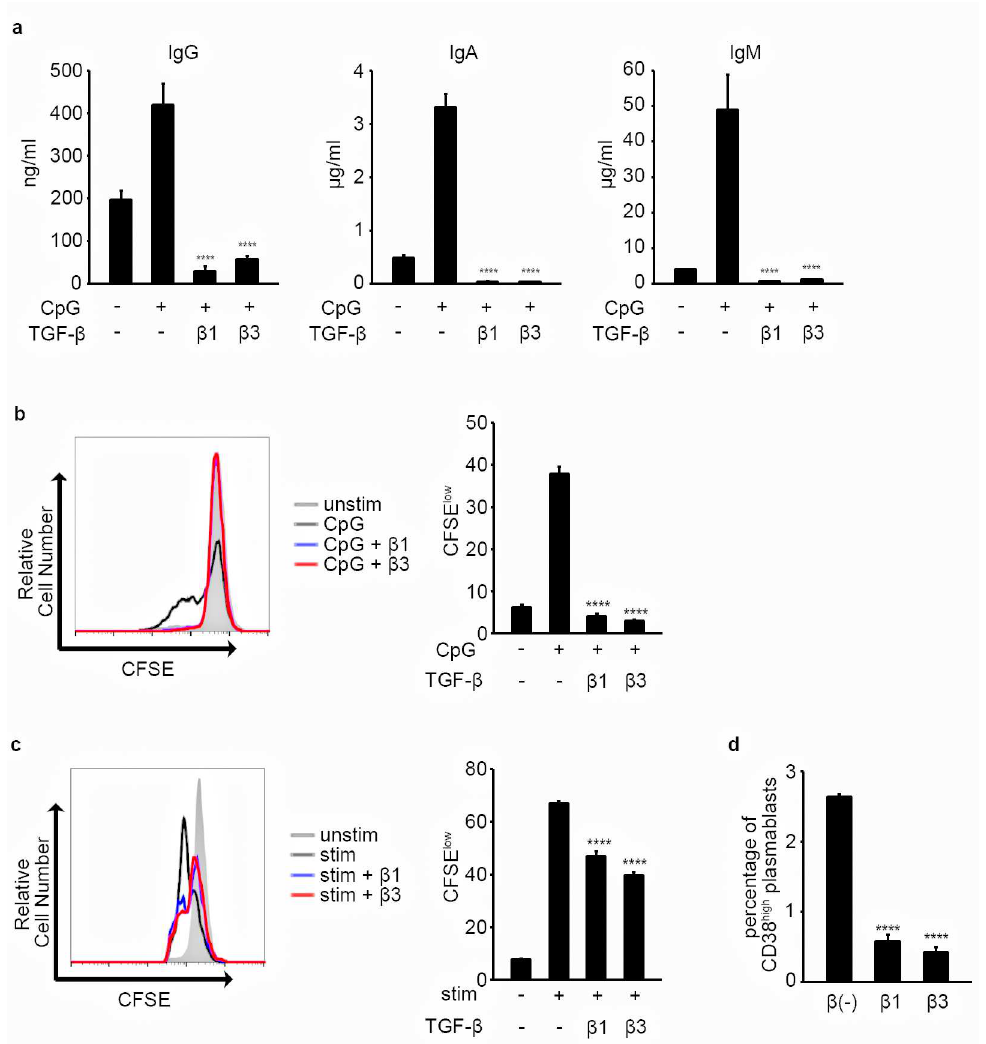
Fig 3. TGF- β 1 and β 3 inhibit B cell function under various stimulatory conditions. (a) B cells were stimulatedwith CpG-ODN2006 for 8 days, and antibody productionwas assessedby ELISA. Among the CpG-ODN2006 stimulated samples, each of the TGF- β treated samples was comparedwith TGF- β untreated sample using one way ANOVA, Dunnett test (n = 3). Results are representative of two independentexperiments. (b) B cells were stimulatedwith CpG-ODN2006for 6 days, and proliferation of CD19 + 7AAD - cells was assessed by flow cytometry. The graph on the right indicatesthe percentage of CFSE low cells amongCD19 + 7AAD - cells. Among the CpG-ODN2006 stimulatedsamples, TGF- β treated cells were comparedwith TGF- β untreatedcells using one way ANOVA, Dunnett test (n = 3). Results are representative of two independentexperiments. (c) B cells were cultured under IL-21, sCD40L, CpG-ODN2006,and BCR stimulationfor 4 days, and proliferation of CD19 + 7AAD - cells was assessed by flow cytometry. The graph on the right indicatesthe percentage of CFSE low cells among CD19 + 7AAD - cells. Among the stimulatedsamples, TGF- β treated cells were comparedwith TGF- β untreatedcells using one way ANOVA, Dunnett test (n = 3). Results are representative of two similar experiments. stim: IL-21, sCD40L, CpG-ODN2006,and BCR stimulation.(d) B cells were cultured under CpG-ODN2006 and BCR stimulationfor 6 days, and the percentageof CD38 high plasmablasts among CD19 + 7AAD - B cells was assessed by flow cytometry. TGF- β treated cells were comparedwith TGF- β untreated cells using one way ANOVA, Dunnett test (n = 3). Results are representative of two similar